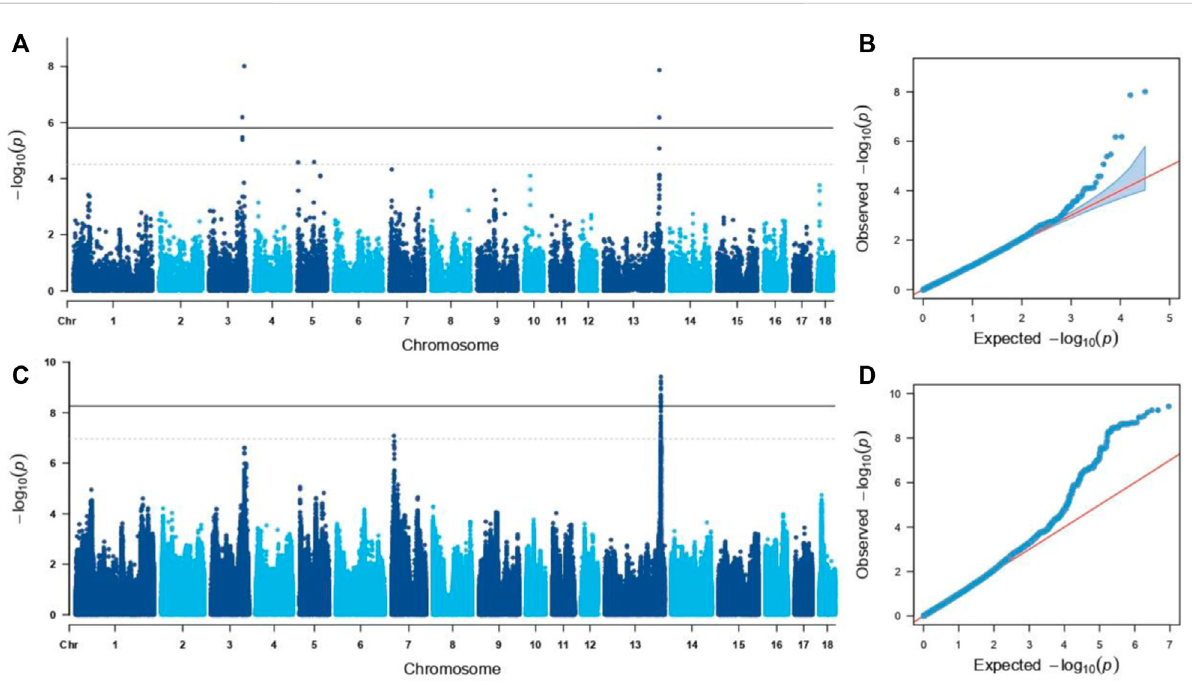
FIGURE 2 Manhanttan and qq plots of GWAS for GL. The solid and dotted lines indicated signi fi cant and suggestive signi fi cant thresholds, respectively. (A,B) . GWAS results based on the GGP Porcine 50K Chip. (C,D) . GWAS results were based on the SNPs